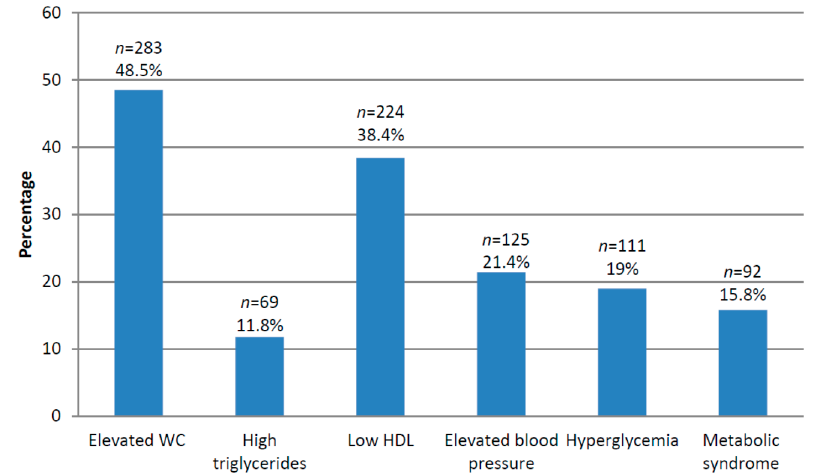
Figure 1. Prevalence of Metabolic syndrome and its abnormalities in the study sample * ( n = 584). The following cut points were used: (1) WC over 88 cm; (2) fasting triglyceride (TG) level over 150 mg/dL (Or on drug treatment for elevated triglycerides); (3) fasting high-density lipoprotein (HDL) cholesterol level less 50 mg/dL (Or on drug treatment for reduced HDL-C); (4) blood pressure ≥ 130/85 mmHg (or on antihypertensive drug treatment in a patient with a history of hypertension); and (5) fasting blood sugar ≥ 100 mg/dL (or on drug treatment for elevated glucose). MetS was defined by the ATPIII criteria, whereby MetS is present if a woman had three or more of the aforementioned five criteria.